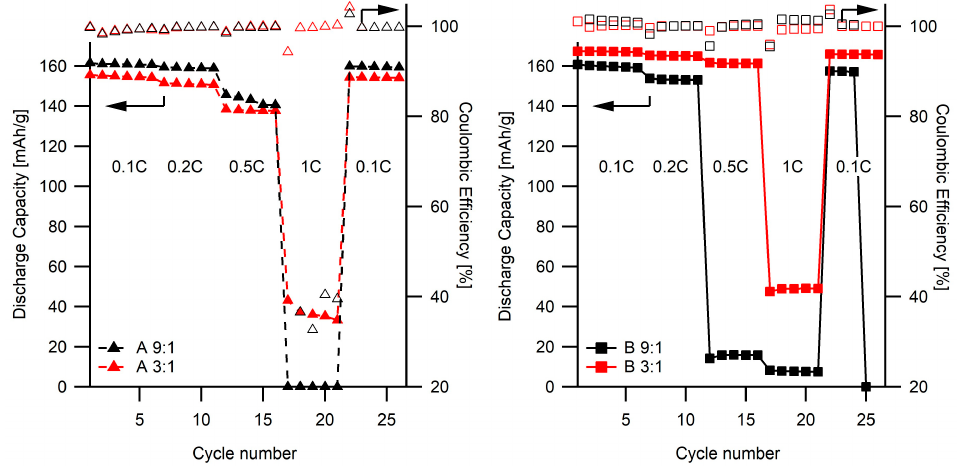
Figure 7. Cycling performance for Li||LFP cells at varying C-rates.